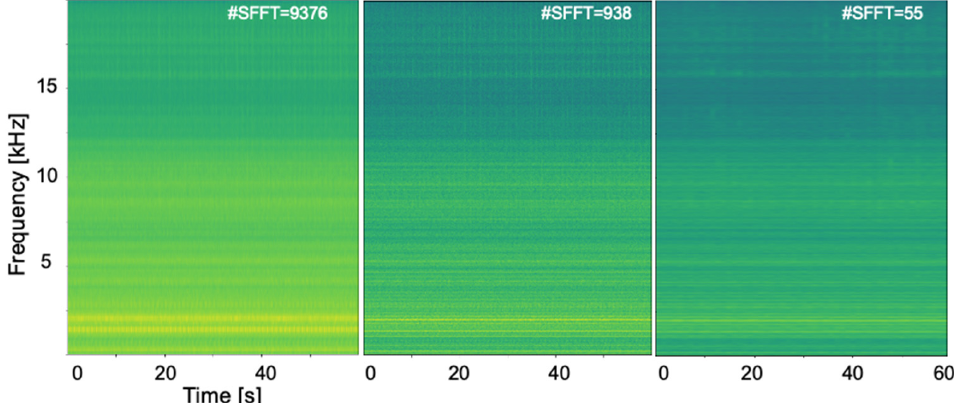
Figure 4. Tradeoff between frequency and temporal resolution depending on the number of short- time Fourier transforms performed per minute (#SFFT) for creating the spectrograms. The longer the input time series to the Fourier transform, the higher the frequency resolution achieved.